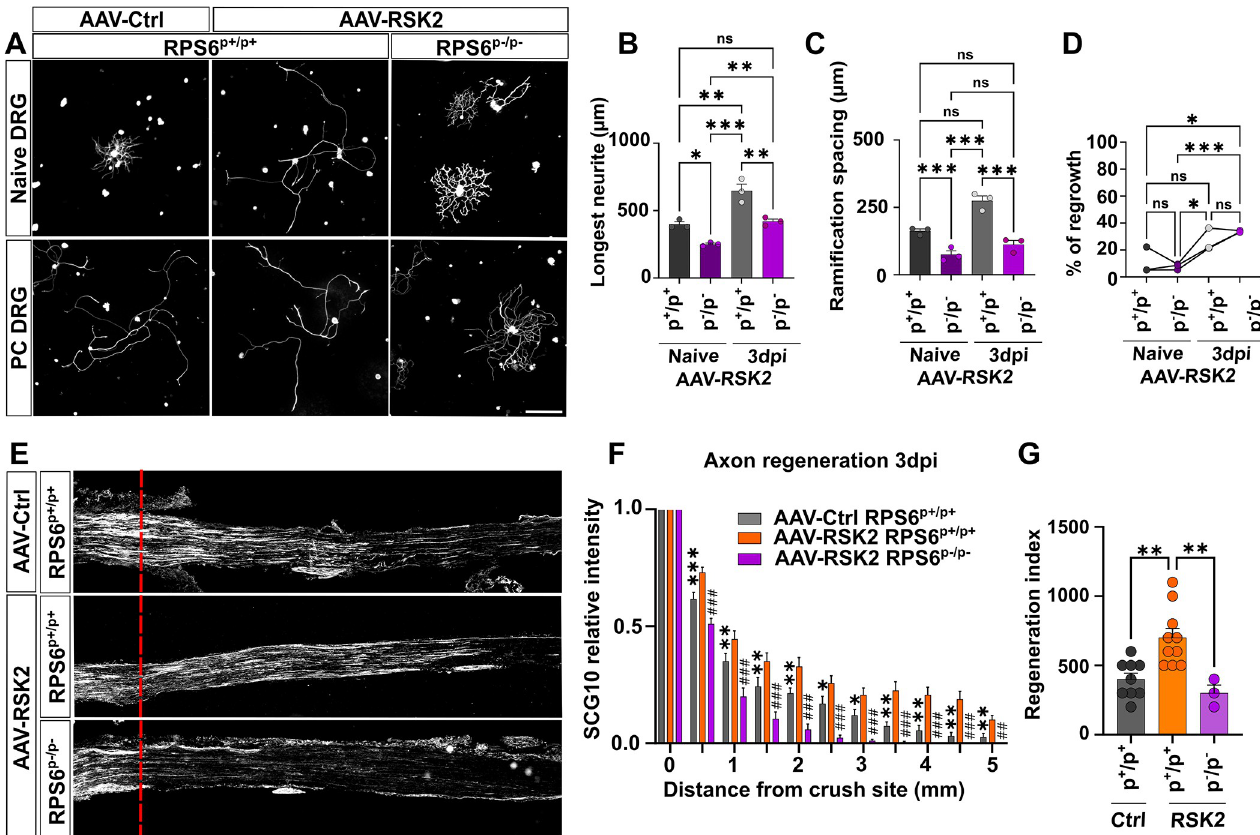
Fig 6. RSK2 needs a phosphorylable RPS6 to induce the preconditioning effect and axon regeneration in the PNS. (A) Representative microphotographs of DRG dissociated cultures showing that RSK2 overexpression phenocopies the preconditioning effect in naive cultures from RPS6 p+/p+ mice but not from RPS6 p-/p- cultures. Scale bar: 250 μ m. (B–D) Quantification of A. (B) Longest neurite length per neuron 16 h after plating (mean ± SEM, Ordinary one-way ANOVA, 3 independent DRG cultures, approximately 50 counted cells per condition per culture). (C) Mean distance between 2 ramifications (mean ±